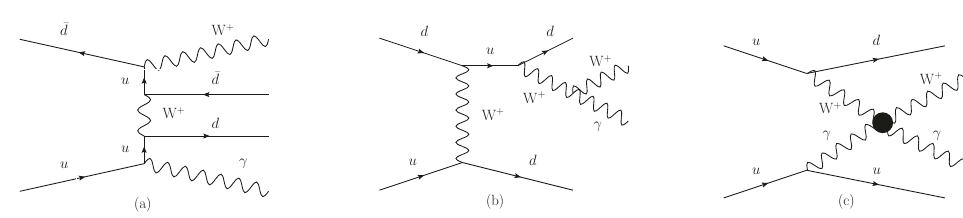
Figure 1 . Representative diagrams for EW W (cid:13) +2 jets production at the LHC corresponding to (a) bremsstrahlung, (b) bremsstrahlung with triple gauge coupling, and (c) VBS with quartic